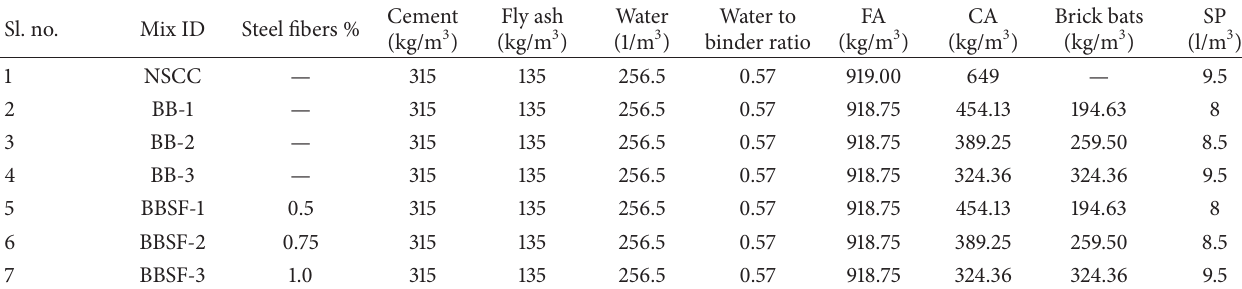
Table 3: Mix proportion.